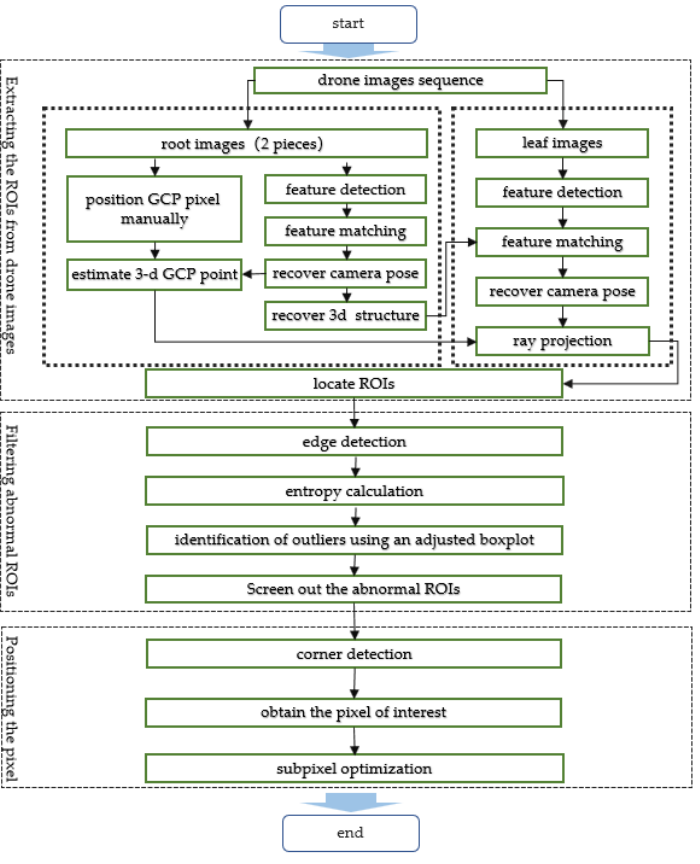
Figure 1. Flowchart of the proposed method. The processes are depicted with big rectangles where the name of each process step is written on the left side, and the sub-processes are shown with small rectangles.